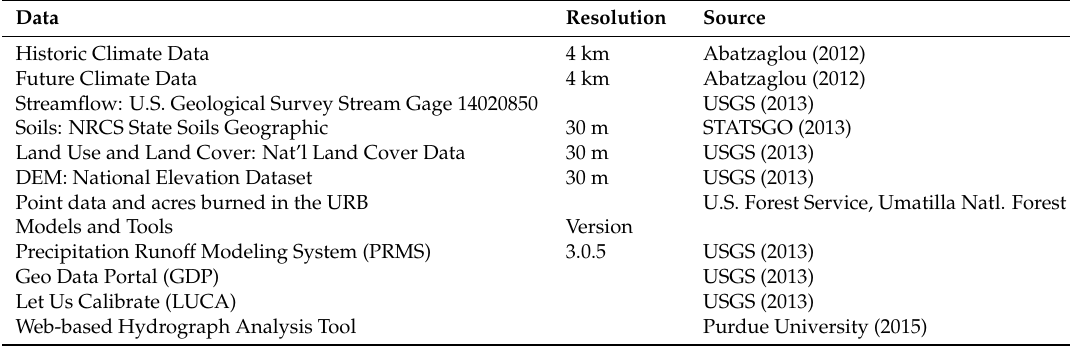
Table A2. Datasets, models and tools used for model parameters and data analysis.